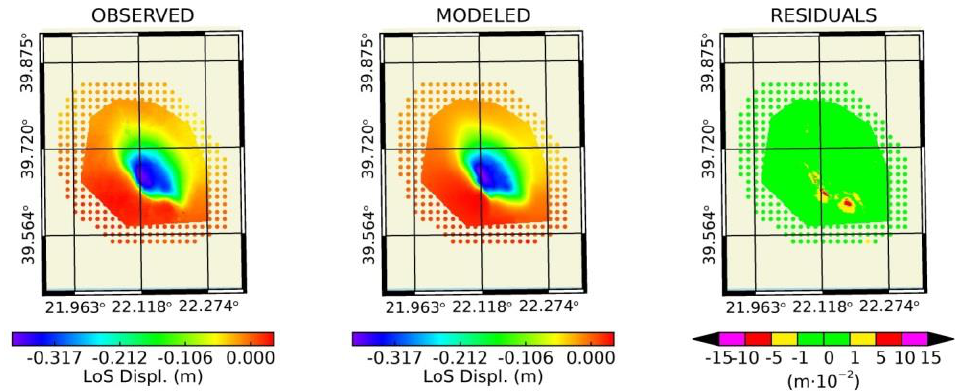
Figure 10. Comparison of LoS displacements from observed and modeled data for the first earthquake (3 March 2021) using the ascending mode.